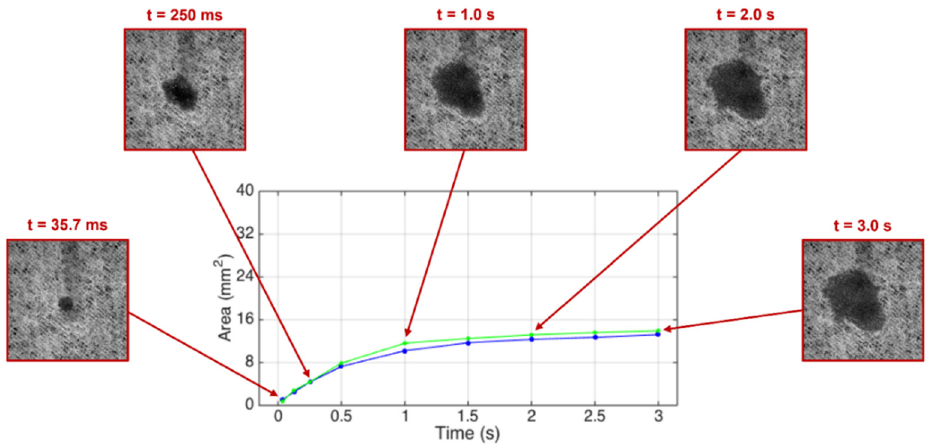
Figure 7. Water spreading area as a function of time for the non-compressed (blue line) and com- pressed (green line) base tissue paper sample A. The insets show the spreading area in different instants of time.